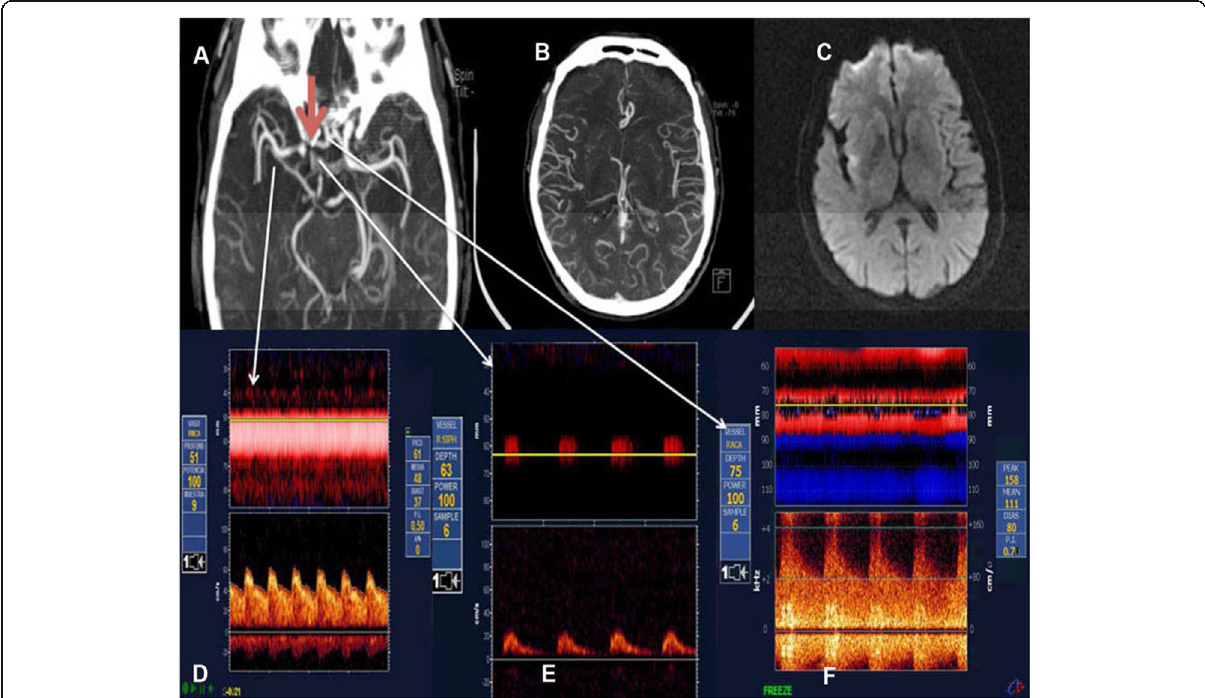
Fig. 2 Case 19: 78-year-old male, arrived within 30 min of symptom onset of a right-side MCA stroke. Initial NIHSS score of 2 points. a CTA interpreted as normal by the neuroradiologist on call; the red arrow demonstrates a short right terminal carotid occlusion. b CTA demonstrates symmetrical filling of both MCA territories, which may be due to collateral flow. c DWI showing small insular ischemic changes. d TCD at the beginning of thrombolysis demonstrates a middle cerebral artery with good flow velocity but with low pulsatility index suggesting post-stenotic flow and a proximal vascular lesion. e Occlusion of right terminal carotid as revealed by the TCD. f Inverted, high velocity flow in the right anterior cerebral artery compatible with anterior cross filling (collateral flow)